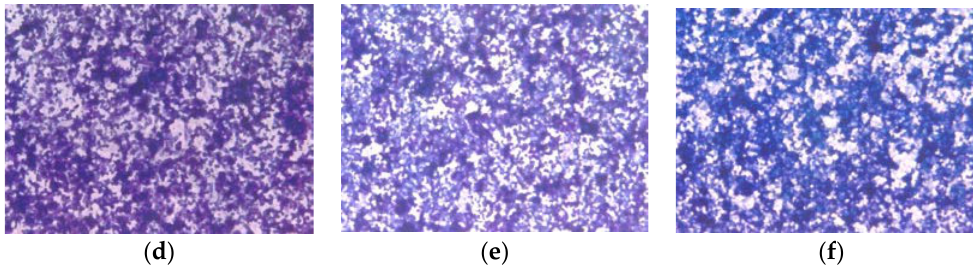
Figure 9. Effect of EPQ on morphology of A-2780 cells: H & E ( a ) Control, ( b ) EPQ 50 μg/mL, ( c ) EPQ 100 μg/mL, ( d ) EPQ 250 μg/mL, ( e ) EPQ 500 μg/mL, ( f ) EPQ 1000 μg/mL.